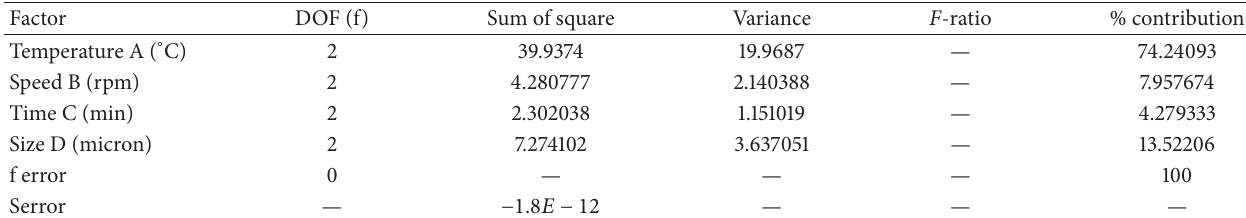
Table 7: ANOVA table.